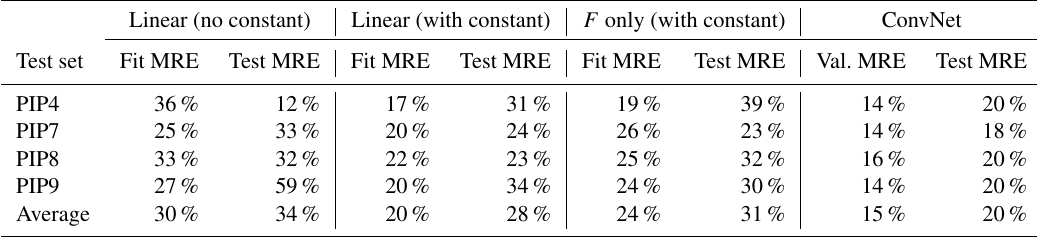
Table 2. A compilation of the MRE of different fitting methods. Coefficients for the linear fits are shown in Table 3 and details are in Sect. 3.2.1–3.2.2. The leftmost column indicates the floe that was excluded from the fitting data (e.g., the first row indicates fits that were performed over the PIP7-9 data and then tested on PIP4). The ConvNet validation error was used for comparison with the linear model fits, as the training error can be made artificially low by overfitting. On average, the ConvNet achieves the best generalization in the fit, even though there are individual anomalous cases. For example, the F -only fit using PIP7 as a test set has a low test error than fit error, which simply means that the average snow / ice ratio for PIP7 is similar to the averaged snow / ice ratio for the other floes. The F -only fit is most comparable to our ConvNet as neither use the snow depth as an input.